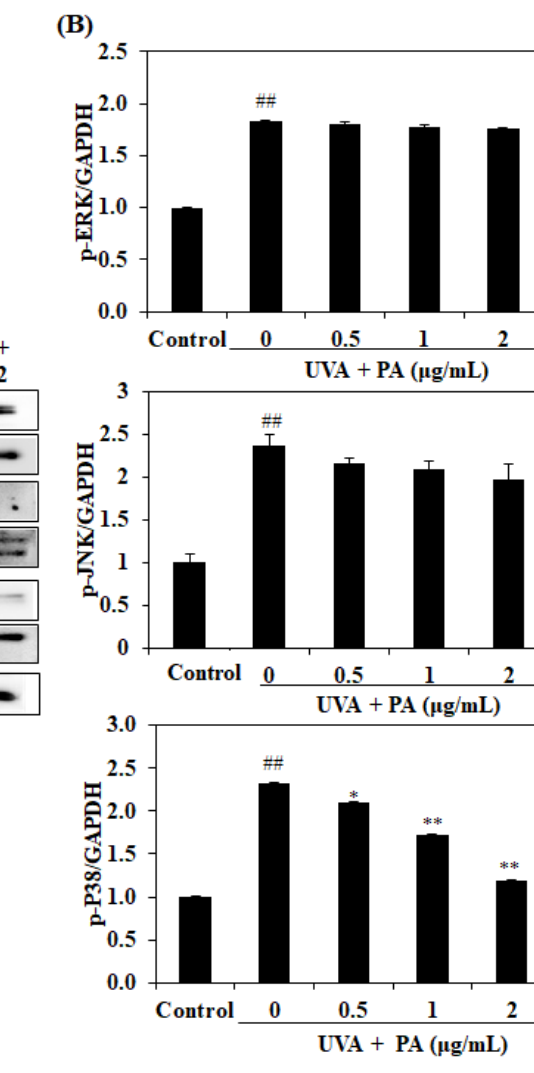
Figure 7. PA suppresses MAPK activation in UVA-irradiated HDF cells. The inhibitory effects of PA on UVA-induced MAPK; ERK, JNK and p38 activation ( A ); and relative activated MAPK levels ( B ). The relative activated MAPK levels were compared with GAPDH. The values are expressed as the mean ± SD in triplicate experiments. ## p < 0.01 indicates a significant difference compared to the control groups. * p < 0.05 and ** p < 0.01 indicate a significant difference compared to the only UVA-irradiated groups.